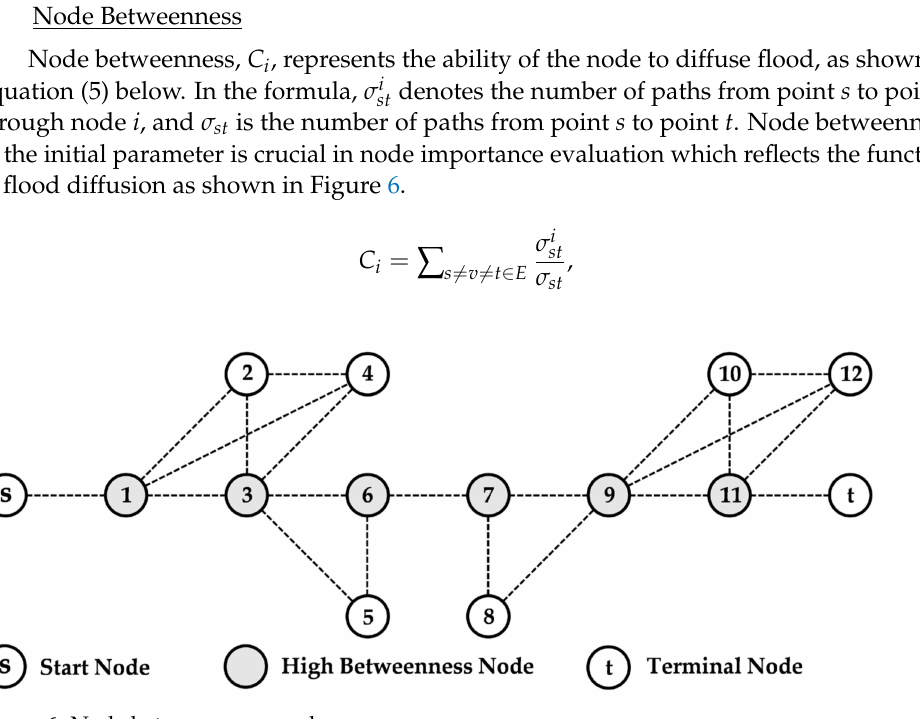
Figure 6. Node betweenness